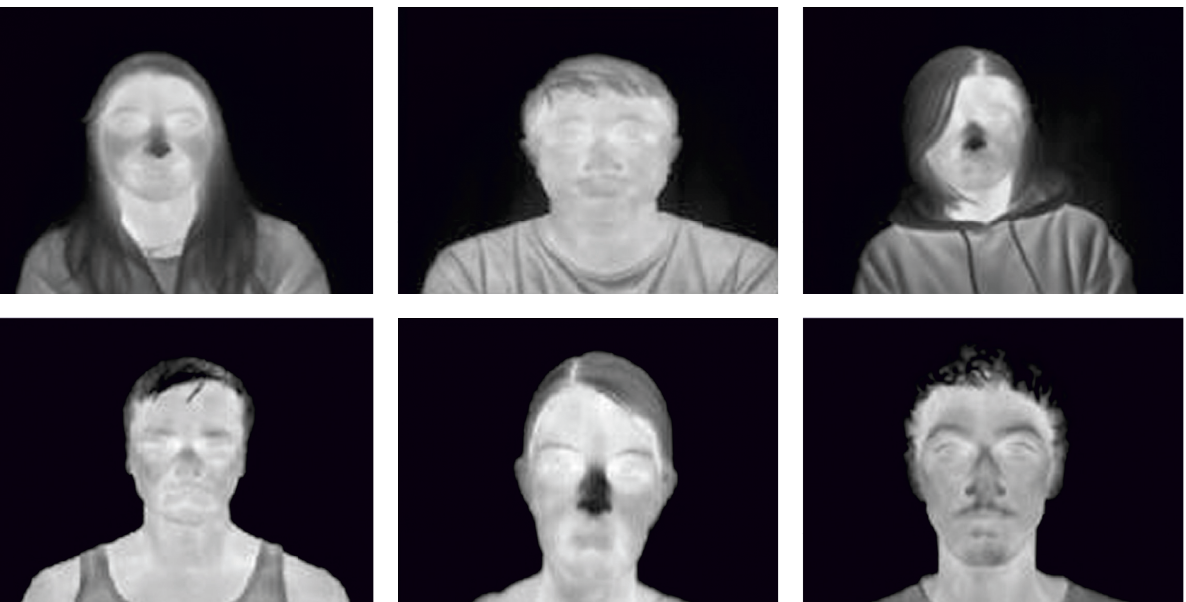
Figure 7: Dataset males and females’ samples (from D1 and D2).